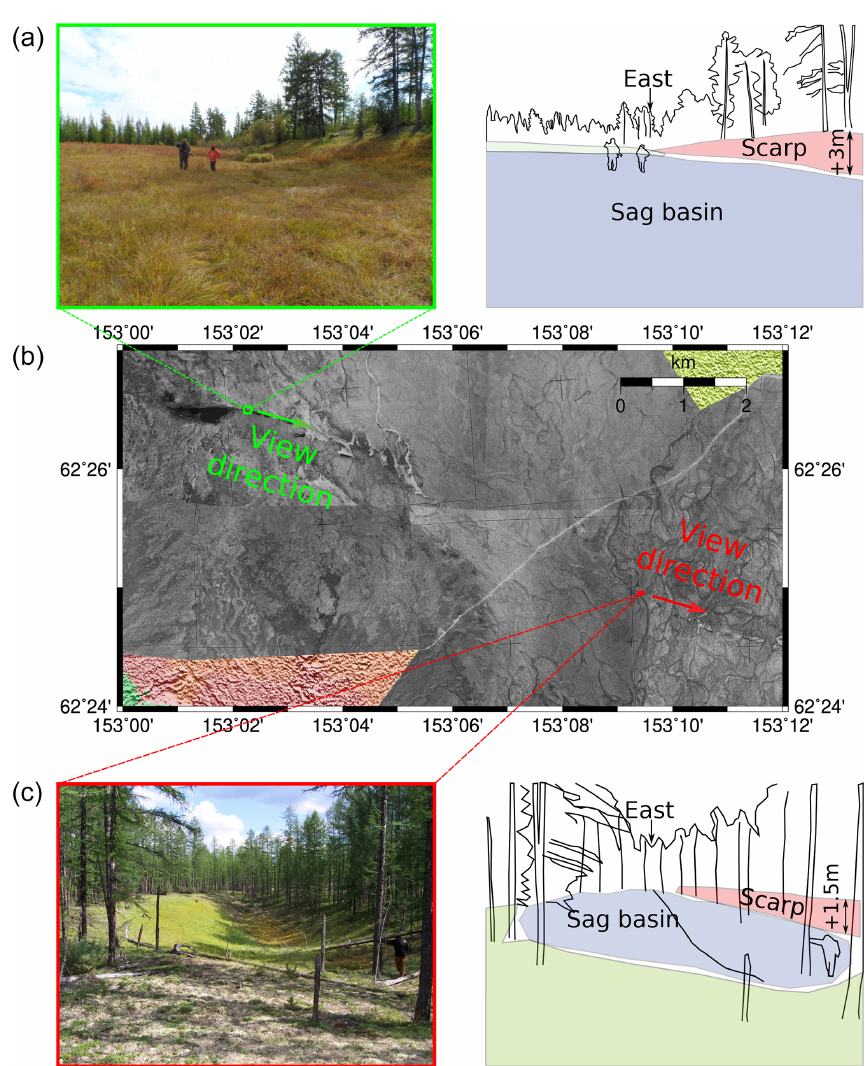
Figure 6. Field photographs and interpretations of the main fault scarp near Lake Rovnoye (a) and a depression with a smaller scarp further east (c) . An aerial photograph (b) shows approximate locations of the views and view